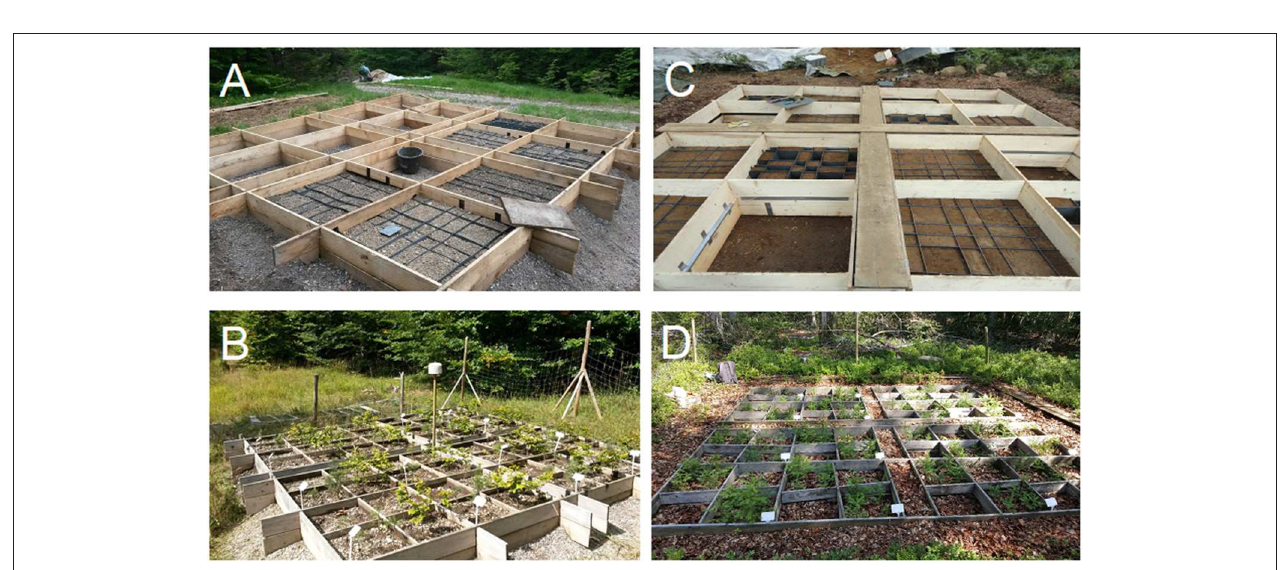
FIGURE 3 | Experiments Achenpass (A,B) and Mitterfels (C,D) . (A,C) Construction stage. (B,D) Experiment conduction stage.